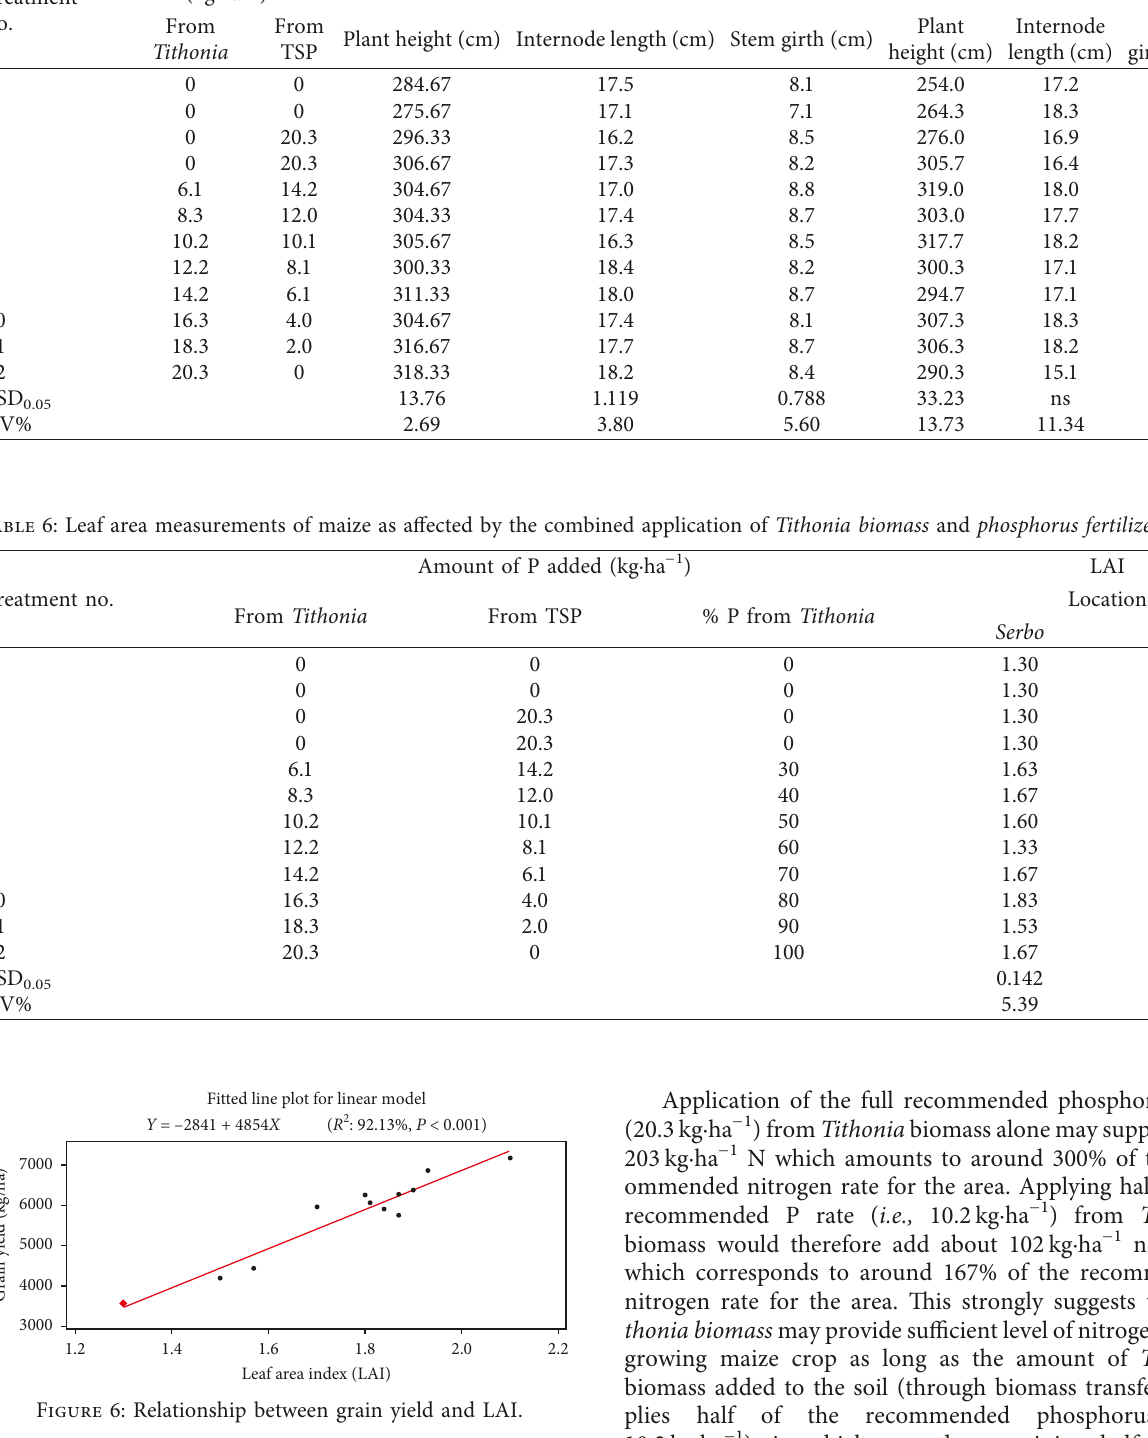
Table 5: Growth characteristics of maize as affected by the combined application of Tithonia biomass and phosphorus fertilizer (TSP). Treatment